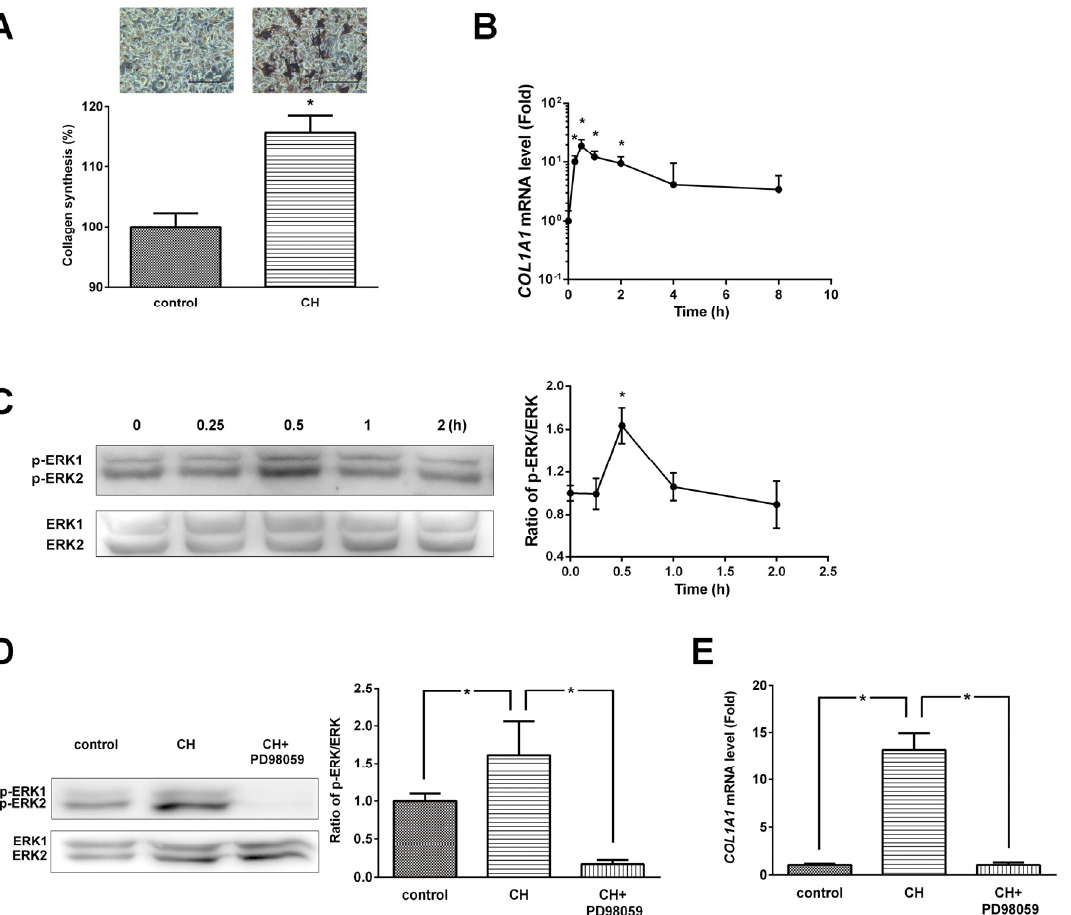
Figure 3. ( A ) Effects of CH on ERK/MAPK pathway mediated collagen synthesis and ( B ) COL1A1 expression in MG63 cells. ( C ) Phosphorylation levels of ERK/MAPK and densitometric results of ERK phosphorylation. ( D ) ERK inhibitor (PD98059) abolished the CH-induced ERK phosphorylation. ( E ) ERK inhibitor (PD98059) inhibited the